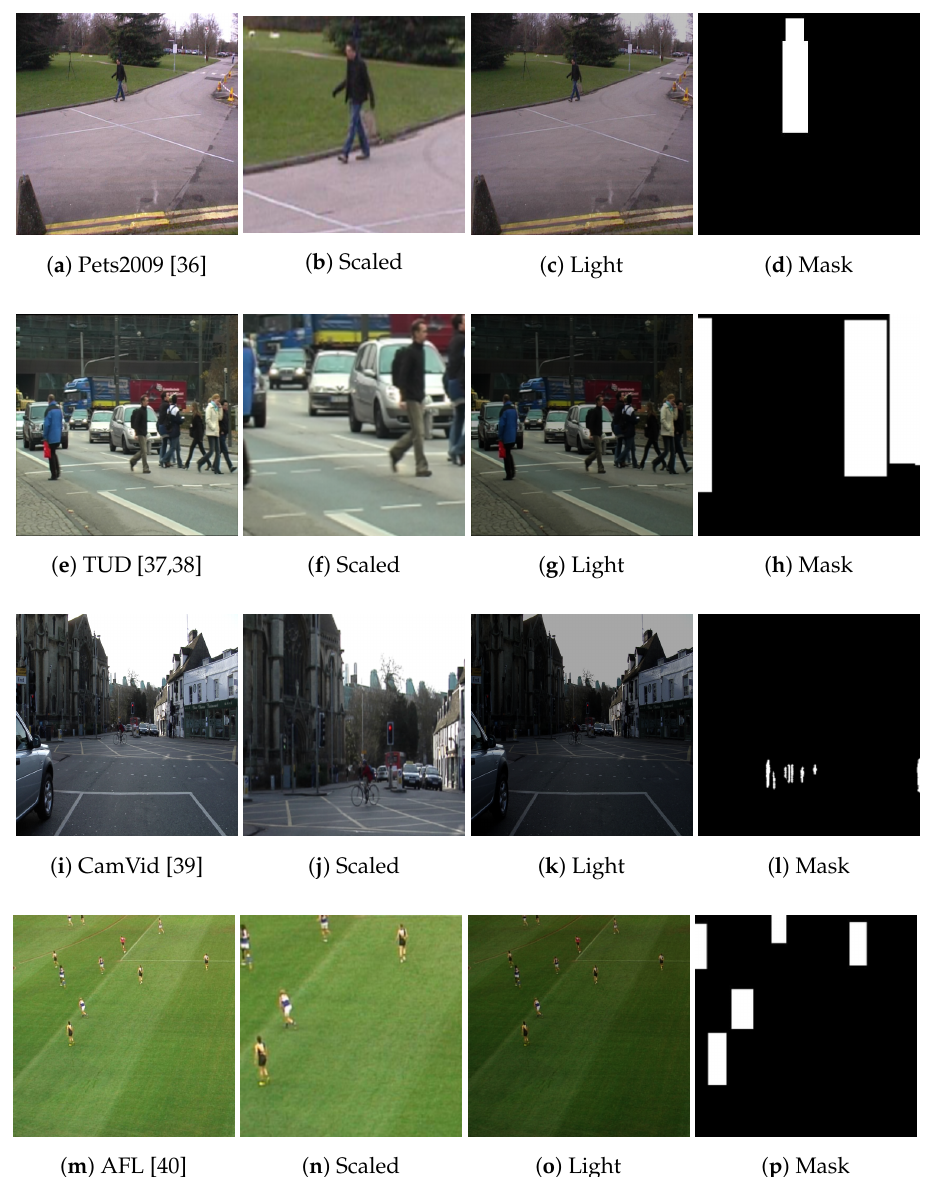
Figure 4. The first column shows the original frame. The 2nd column corresponds to the scaled version of the frame. The third column shows different lighting condition that is introduced through the Gaussian noise and gamma correction. The fourth column corresponds to the binary mask for training the